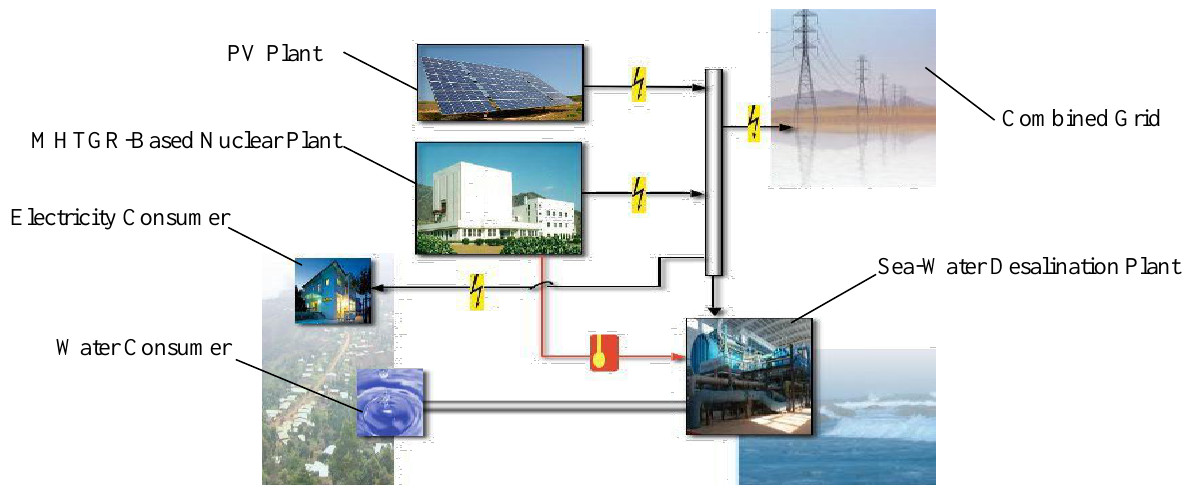
Figure 2. A micro-grid constituted by nuclear fission and photovoltaic